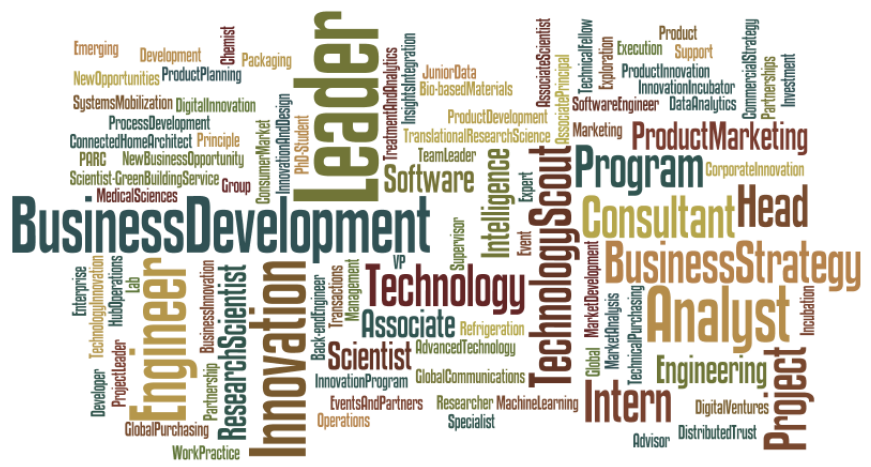
Fig. 2. Word buzz of job titles in the field of open